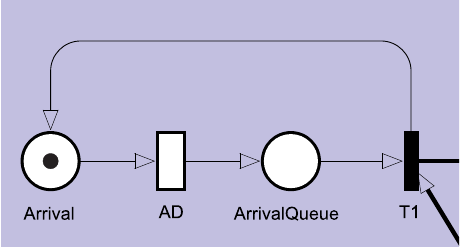
Figure 4. Admission submodule responsible for generating new requests following a specific probability